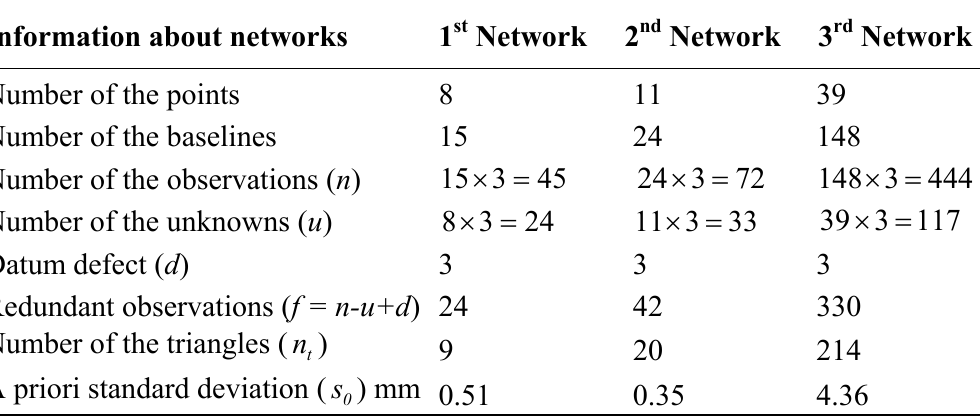
Table 3. Properties of the GPS